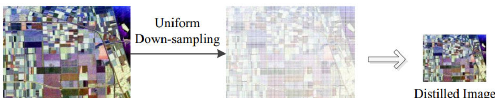
Figure 1. Uniform down-sampling for entire polarimetric synthetic aperture radar (PolSAR) image, resulting in a small image with the same region and structure as the entire image.